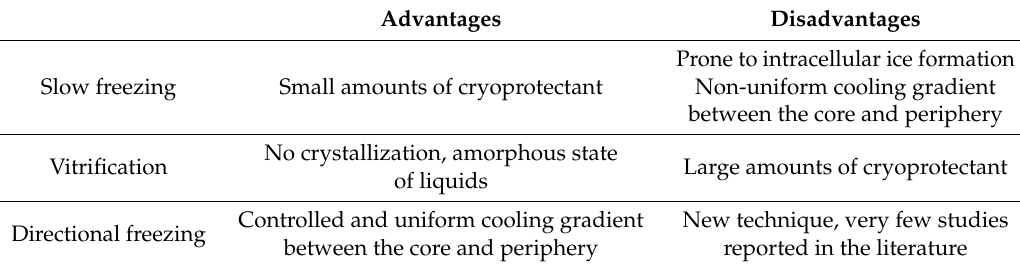
Table 2. Comparison of di ff erent freezing